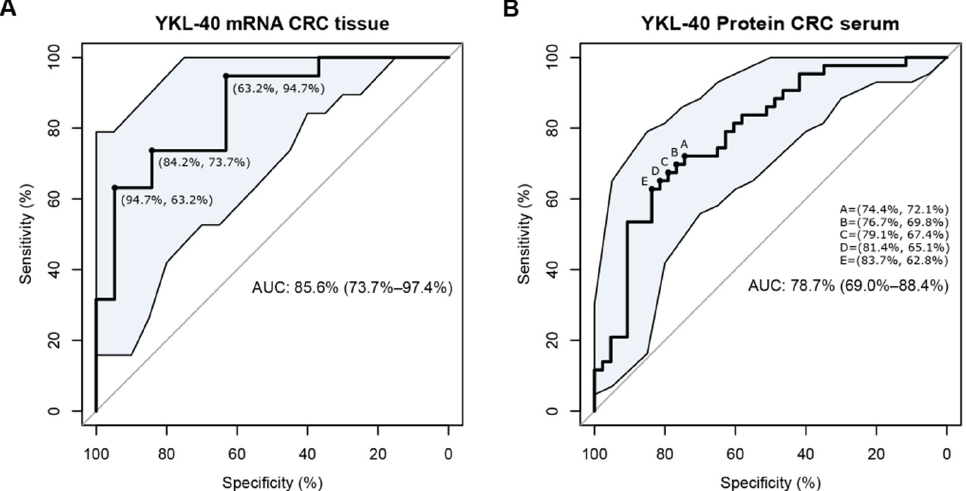
Figure 5. Diagnostic performance of YKL-40 mRNA levels in CRC tissues (H) and YKL-40 protein levels in CRC serum. Receiver operating characteristic (ROC) curve analysis in ( A ) CRC tissue samples ( n = 19) and colon mucosa derived from cancer-free subjects ( n = 19); area under the curve (AUC) = 85.6 (95% CI: 73.7–97.4%, p = 0.0002); ( B ) tumor serum samples ( n = 43) and serum samples derived from cancer-free subjects ( n = 43); area under the curve (AUC) = 78.7 (95% CI: 69.0–88.4%, p = 0.000004).